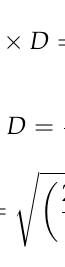
Figure 23. Maximum speed of a Vehicle given the braking distance with different masses of the vehicle. 4.6. Required Braking Force Given the Mass and the Speed to Yield the Same Braking Distance